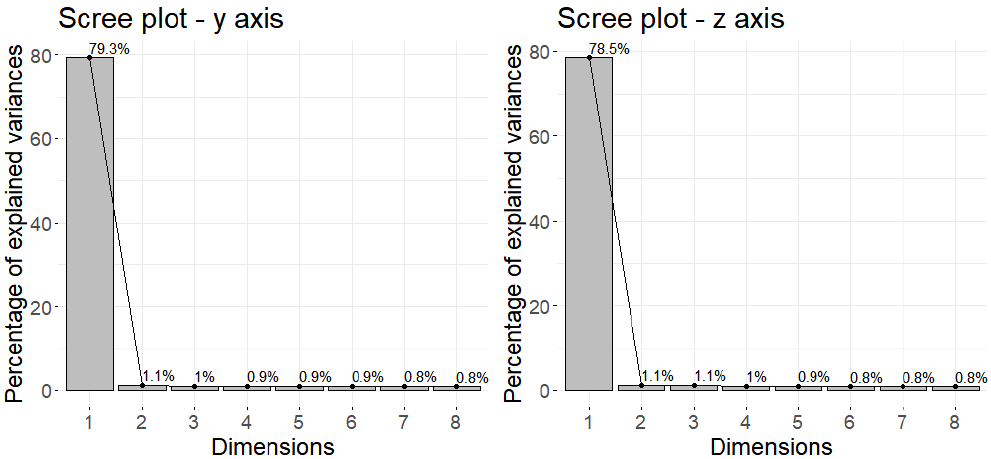
Figure 9. Scree plot for the radial-ulnar — y-axis (S1) and proximal-distal z-axis (S2).